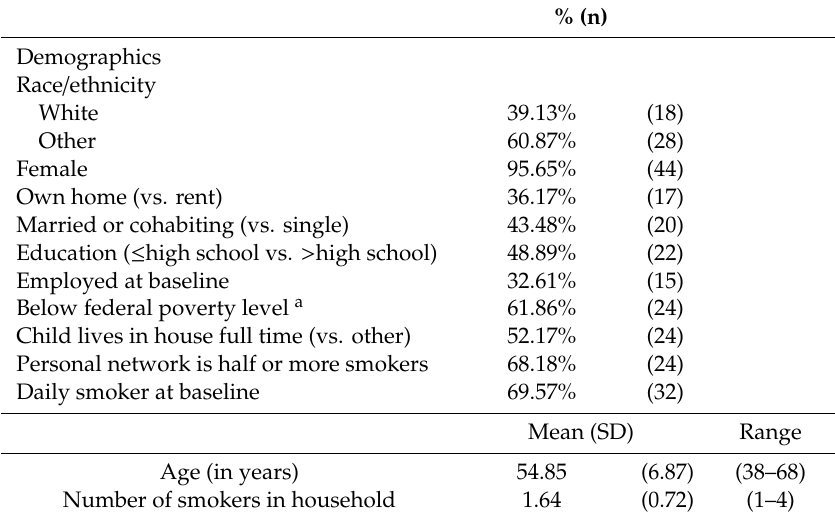
Table 2. Descriptive Statistics for Analytic Sample with Full Baseline